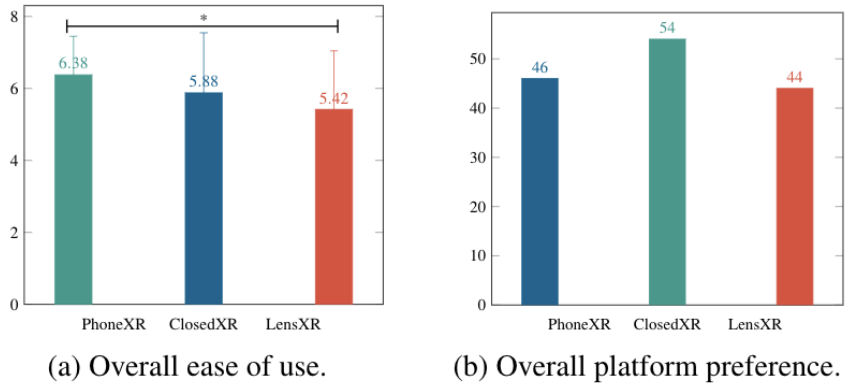
Figure 9. Survey results regarding the overall ease of multi-mode and multitasking experience and general preference. Statistical differences are indicated with the “*” mark and illustrated by color grouping. The vertical axes represent the subjective levels in the 7-point Likert scale ( a ), and the preference scores ( b